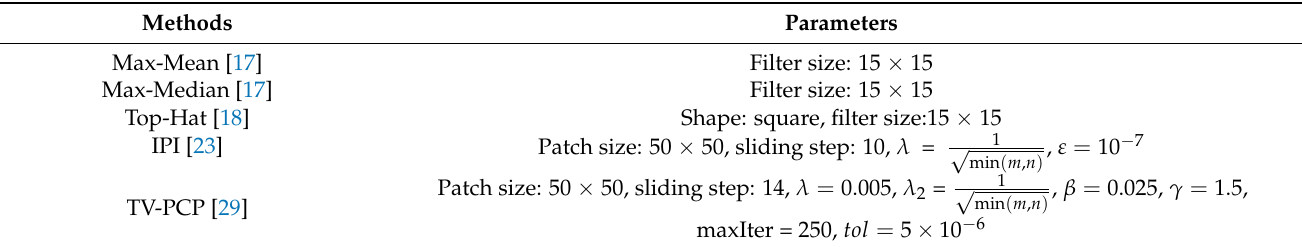
Table 1. Detailed parameters of baseline methods.